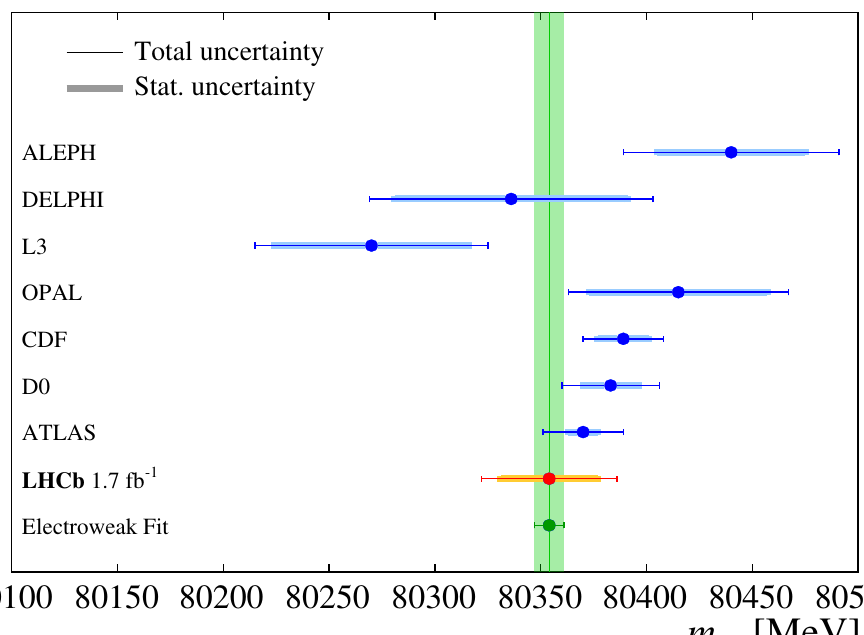
Figure 13 . Measured value of m W compared to those from the ALEPH [62], DELPHI [63], L3 [64], OPAL [65], CDF [10], D0 [11] and ATLAS [12] experiments. The current prediction of m the global electroweak fit is also